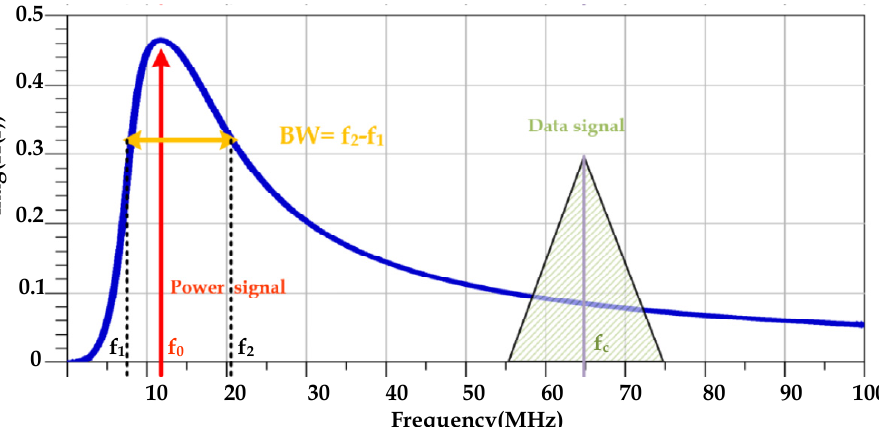
Figure 4. |H(f)| of the resonant inductive (e.g., f 0 ∼ = 10 MHz) of the channel formed by the two-coil system with a coupling factor k 12 = 0.5. The spectrum of the modulated HF data sideband is shown by the data carrier frequency (i.e., f c = 65 MHz) along with baseband signal bandwidth. For example, let us suppose that f c = f 0 = 10 MHz and high Q = 50; therefore, BW = 200 kHz. The data rate is approximately equal to 100 kbps when the load